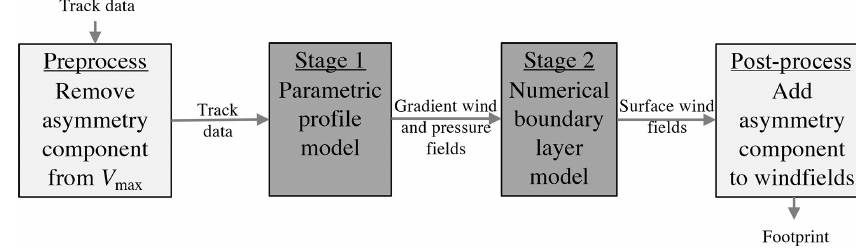
Figure 1. Workflow diagram of the two-stage modelling process, bookended by pre- and post-processing steps.